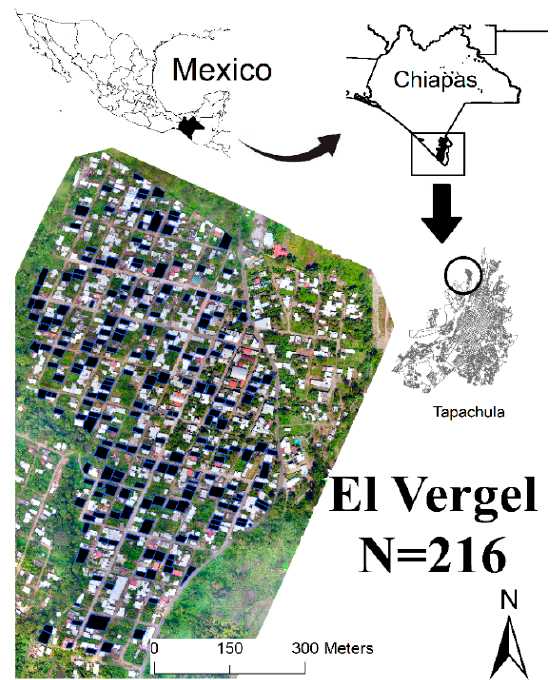
Figure 1. Geographical representation of the study area, El Vergel neighborhood, north of Tapachula city and municipality, in the far southeast of Chiapas, Mexico. The black rectangles represent the study dwellings.